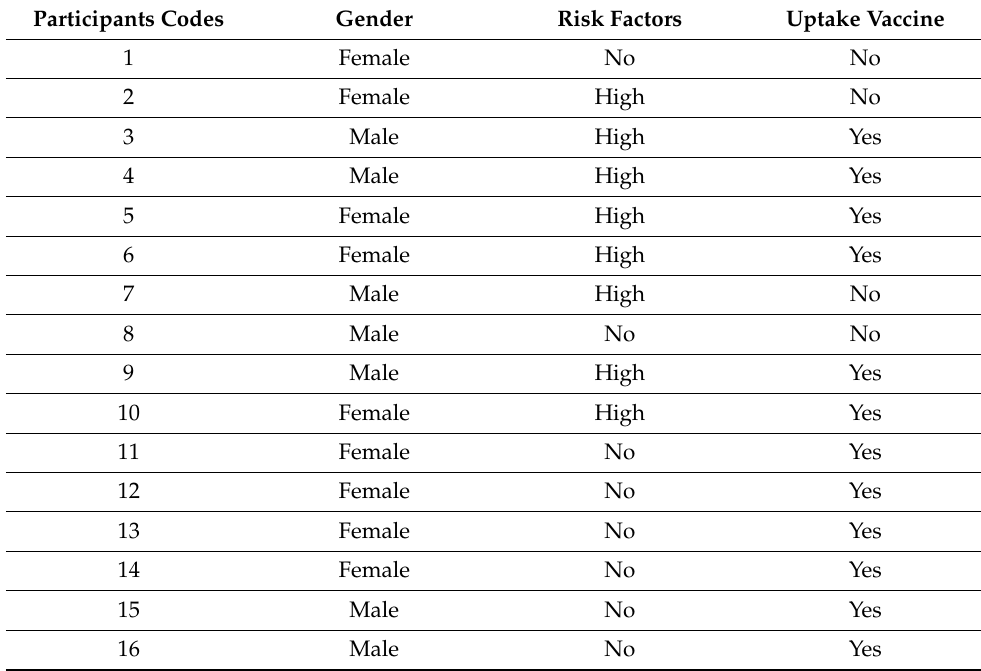
Table 2. General characteristics of vaccine